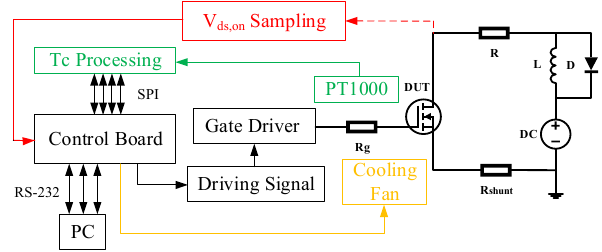
Figure 1. Schematic diagram of the experimental setup.